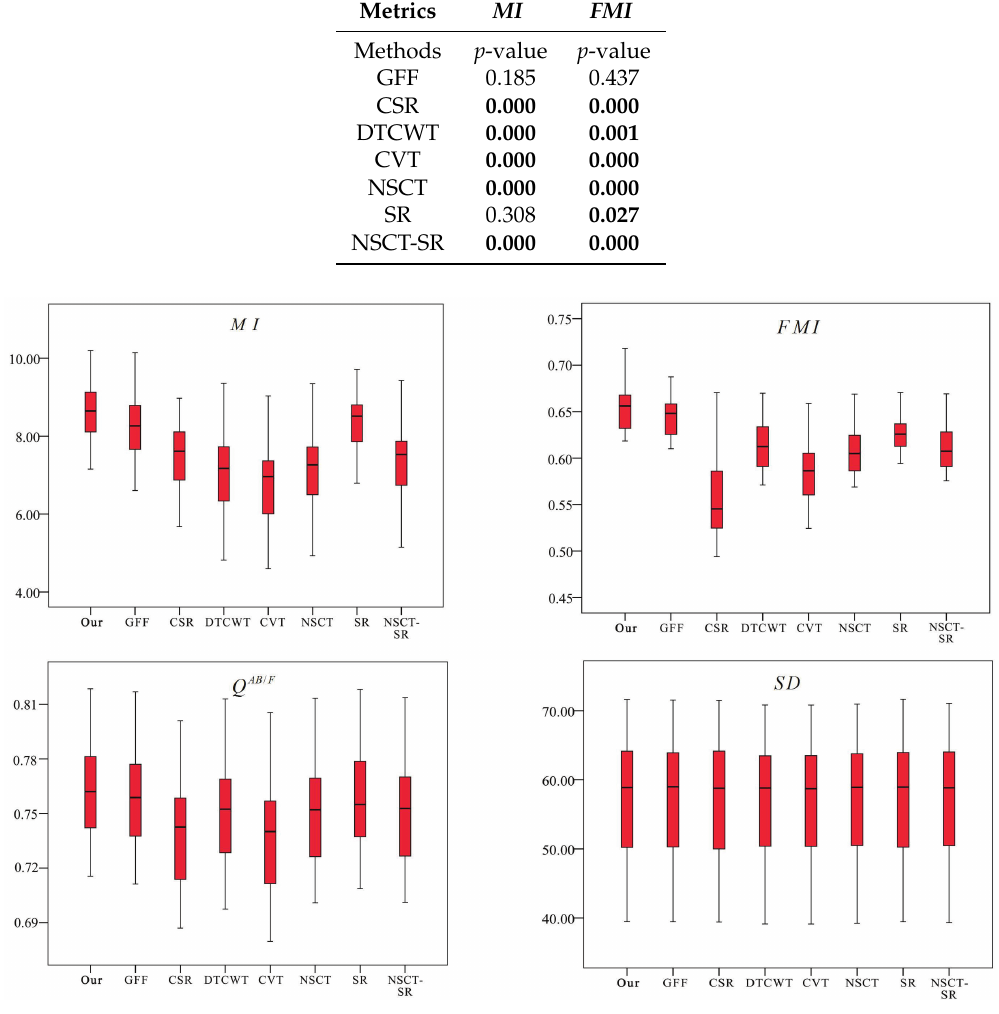
Figure 13. Boxplots of the statistical